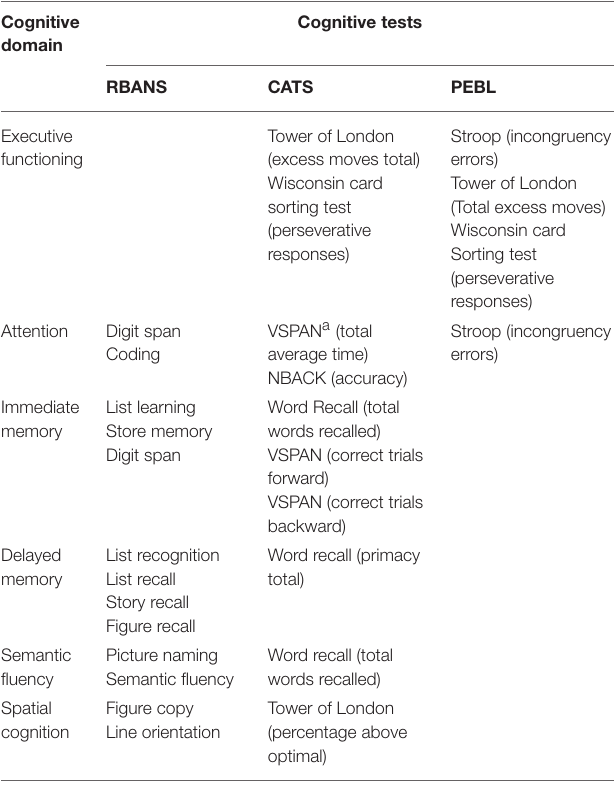
TABLE 1 | Calculation of composite domain-specific z -scores by cognitive domain in the RBANS, CATS, and PEBL batteries. Cognitive